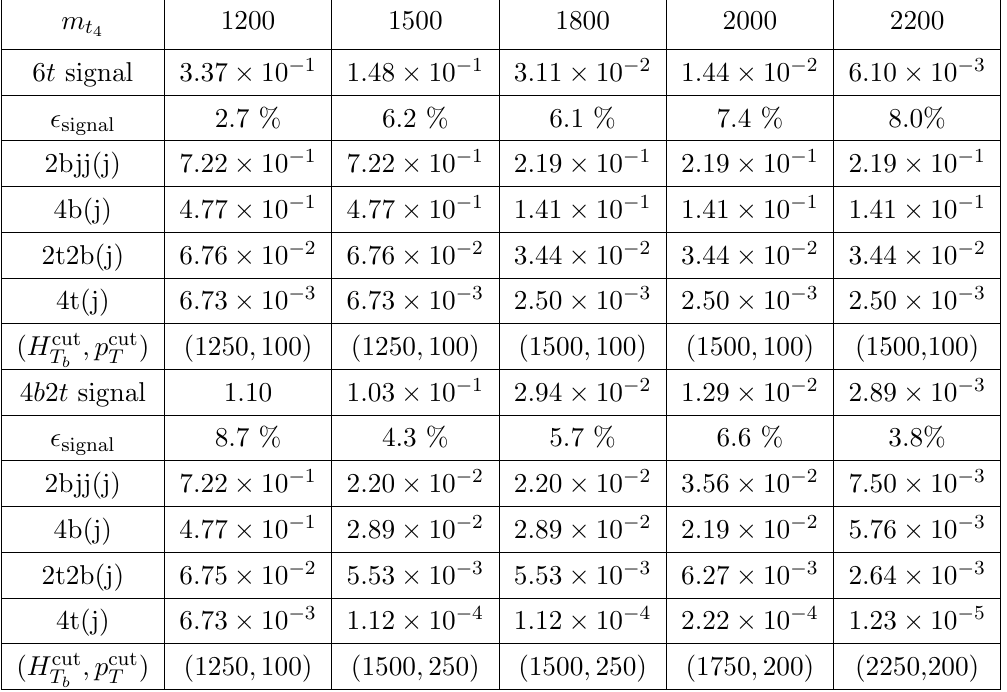
Table 2 . Signals pp t 4 t 4 t 4 t 4 6 t , pp 4 b 2 t and background (cid:12)ducial cross sections in units ! ! ! ! of fb in the 4b analysis. For each t 4 mass hypothesis, the optimized cuts are listed in the last row for integrated luminosity L = 3 ab (cid:0) 1 . The signal e(cid:14)ciency of the cuts ( (cid:15) ) is also presented. All results are presented using the 1b/2b-tagging working point ( (cid:15) 1 b ; (cid:22) (cid:15) 2 b ) = (0 : 8 ; 1 = 3).